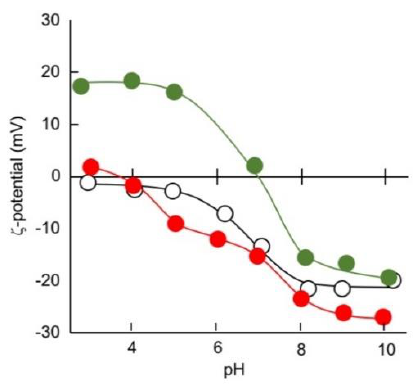
Figure 6. pH dependencies of the ζ-potential of Sil-0 ( –– ), Sil-P 17 /H 75 -0 ( –– ), and Sil-P 17 /H 75 -H 560 ( –– ).